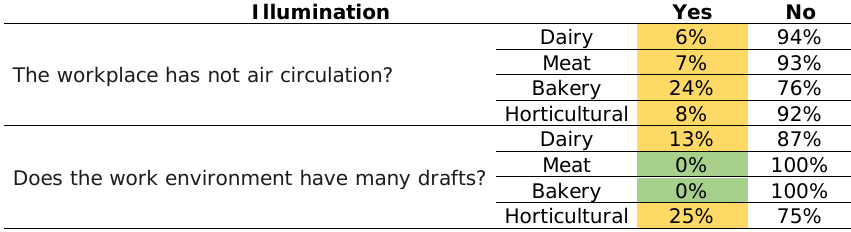
Table 6. General ventilation analysis of the audited companies